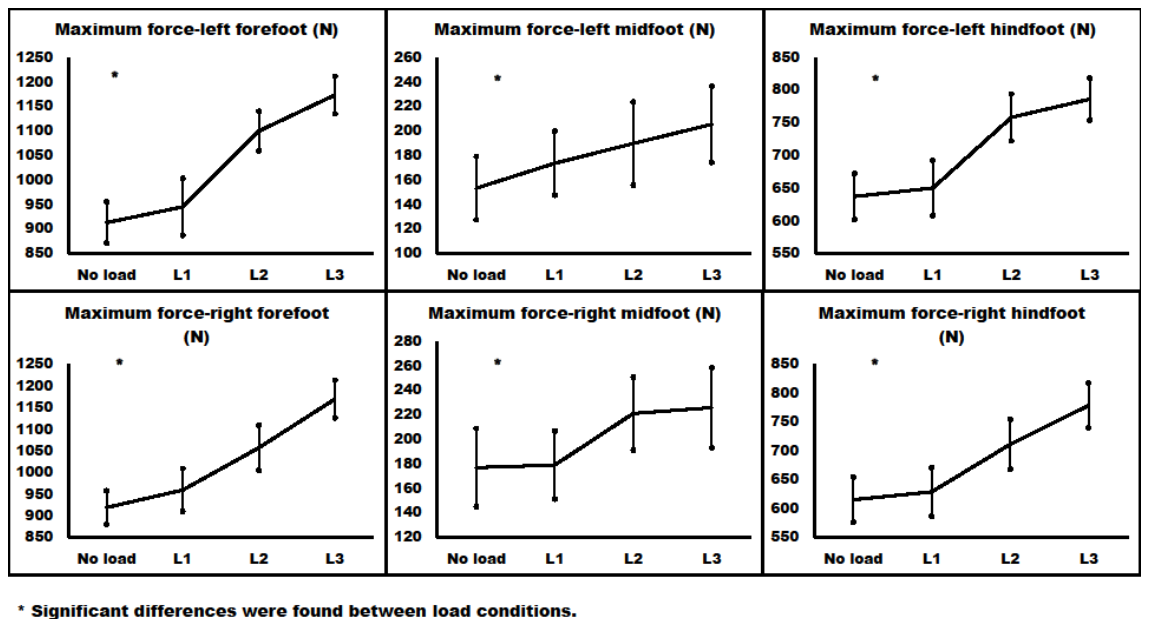
Figure 3. Changes in ground reaction forces beneath specific foot regions under different loading conditions of no load (only body weight), L1 (5 kg load), L2 (25 kg load) and L3 (45 kg load), (N = 30).